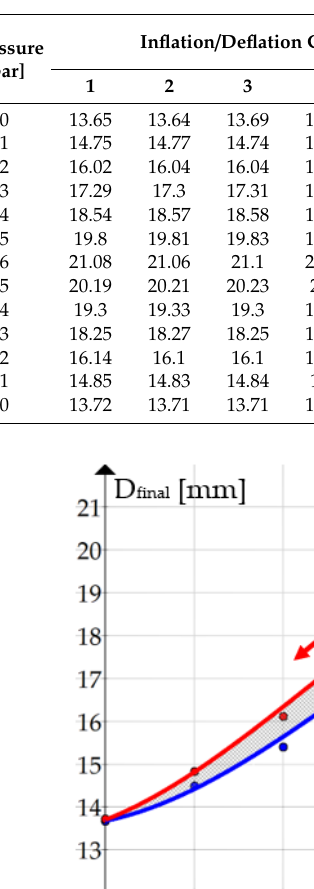
Table 2. Muscle diameters for zero external load.